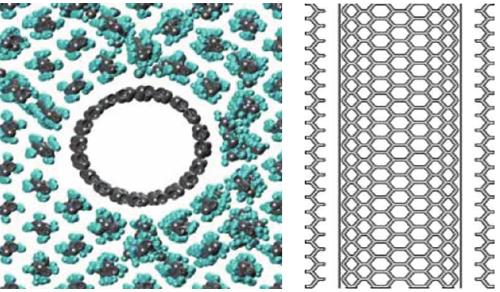
Figure 5: The molecular structure of nanocomposite crystallic